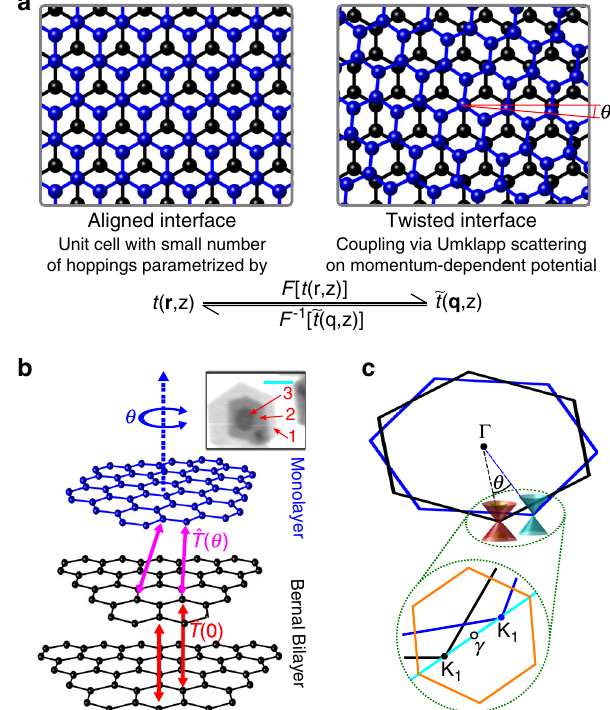
Fig. 1 Aligned vs twisted interfaces in van der Waals heterostructures. a Comparison of aligned and twisted interfaces for two-dimensional crystals and the descriptions in the real and reciprocal spaces used in this article. Blue and black balls indicate atoms in the top and bottom layer, respectively. b Schematic of twisted trilayer graphene with monolayer (blue) stacked at an angle on top of a Bernal bilayer (black). The red and purple arrows indicate the interlayer couplings for the Bernal and twisted interfaces which are captured by the blocks ^ T ð 0 Þ and ^ T ð θ Þ , respectively, in the Hamiltonian in Eq. (1). Inset shows photoemission intensity from copper substrate which is attenuated by graphene layers above, providing a measure of graphene layer number. The red arrows indicate each of the graphene layers in the trilayer stack and the cyan line corresponds to the distance of 10 μ m. c Brillouin zones of the Bernal bilayer (black) and rotated monolayer (blue) with bilayer and monolayer graphene low-energy electronic spectra shown in the vicinities of one set of the Brillouin zone corners. The inset depicts in orange the superlattice Brillouin zone and the cyan line indicates the k -space path cuts along which are presented in Figs. 2a and